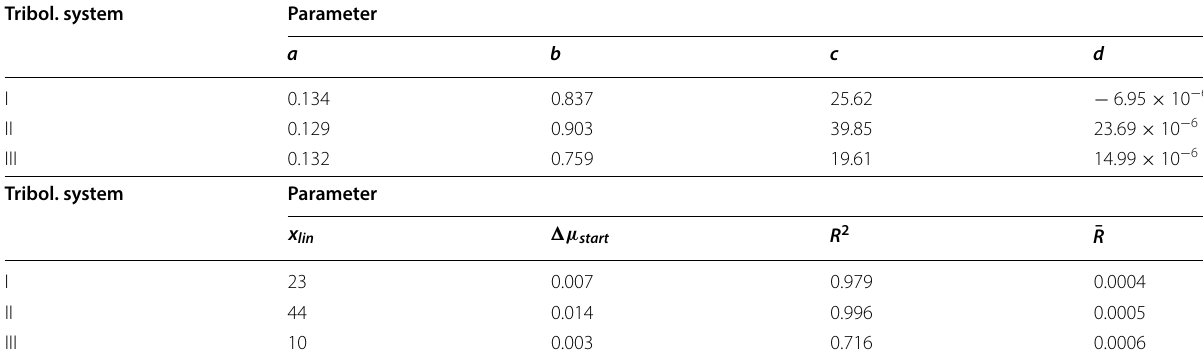
Table 3 Running‑in behavior of different tribological systems: results of test method being introduced in Section 3 Tribol.